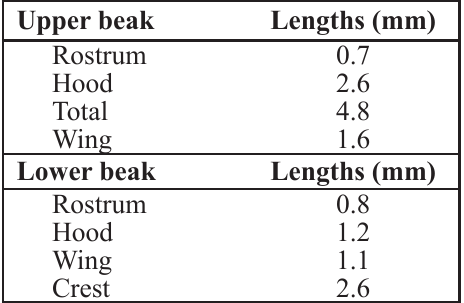
Table 2. Measurements taken on beaks of the paratype, ♀, ESFM-CEP/1994-2, of Sepiola boletzkyi sp. nov., definitions according to Clarke (1986) and Açik & Salman